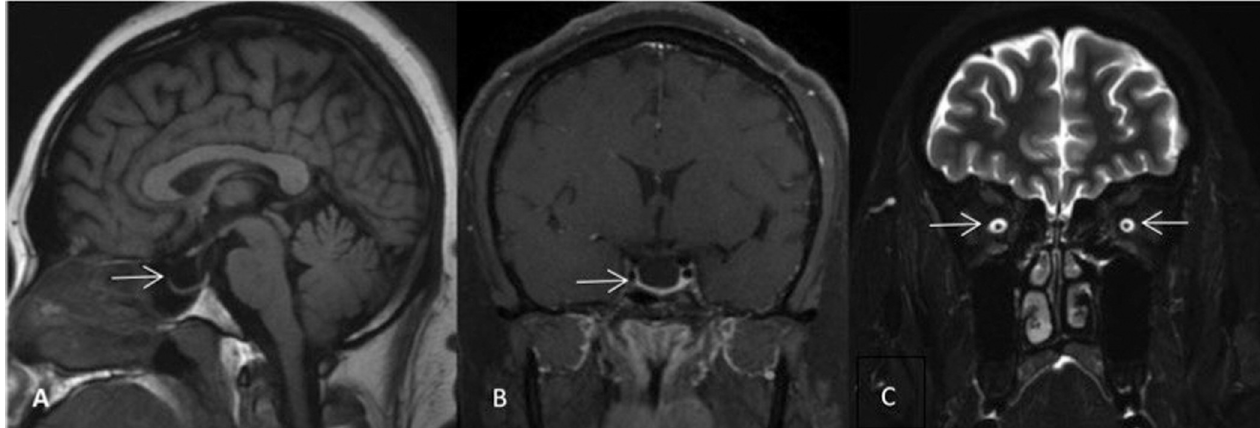
Fig 2. Common imaging findings caused by IIH. A and B showed empty sella on T1WI sequence; C showed DPSS in both eyes on coronal fat-depressed T2WI sequence.